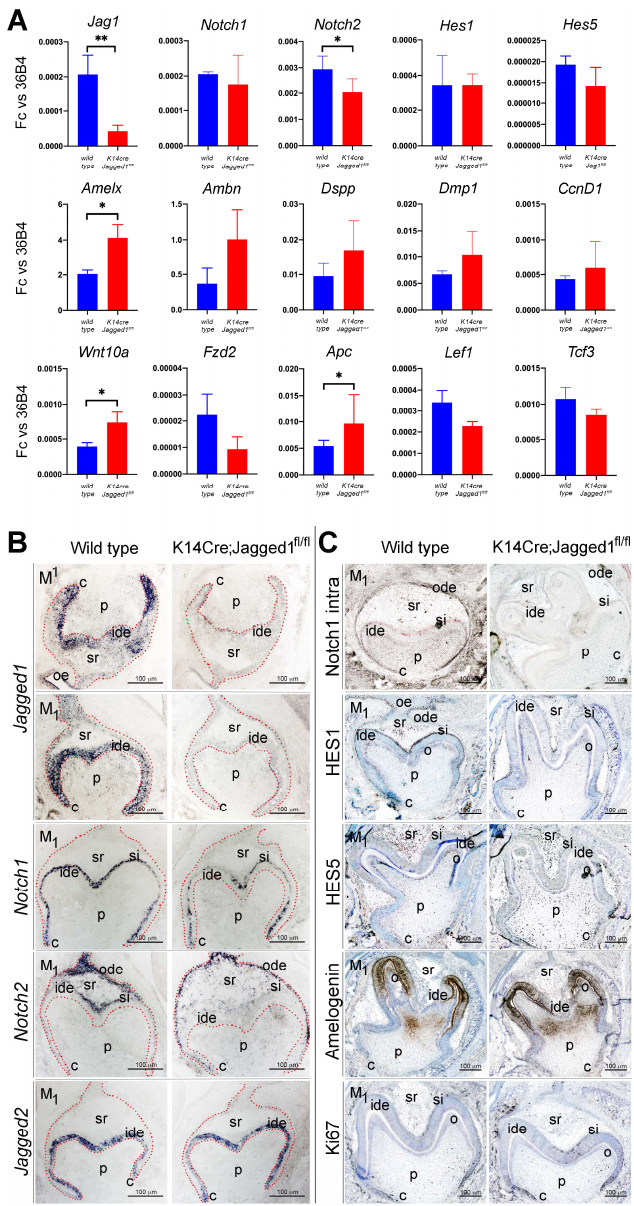
Figure 4. Expression analysis of genes and proteins in E18.5 WT and K14Cre;Jagged1 fl/fl teeth. ( A ) RT-PCR analysis of the expression of genes coding for components of the Notch pathway (i.e., Jag1, Notch1 , Notch2 , Hes1 , Hes5 ), Wnt signaling pathway (i.e., Wnt10A , Fzd2 , Apc , Lef1 , Tcf3 ), various ameloblast (i.e., Amelx , Ambn ) and odontoblast (i.e., Dspp , Dmp1 ) differentiation markers, and a proliferation marker (i.e., CcnD1 ), in both WT (blue color) and mutant (red color) first molars. Statistical analysis used Student’s t-test (significant difference at *, p < 0.05; **, p < 0.01). ( B ) In situ hybridization showing alterations in the expression pattern of Jagged1 , Notch1 , Notch2 and Jagged2 in mutant first molars when compared to WT ones. ( C ) Immunohistochemistry showing modifications in the distribution pattern of the active form of Notch1 (Notch1 intra), Hes1 and Hes5 proteins, the enamel-specific Amelogenin protein and the nuclear Ki67 protein (cell proliferation marker) in K14Cre;Jagged1 fl/fl teeth when compared to WT teeth. Scale bars 100 µ